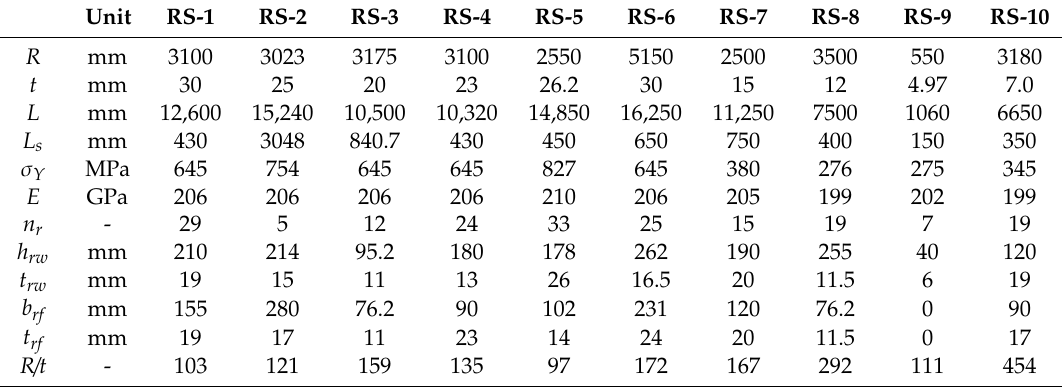
Table 7. Material properties and scantlings of the ring-sti ff ened cylinders.